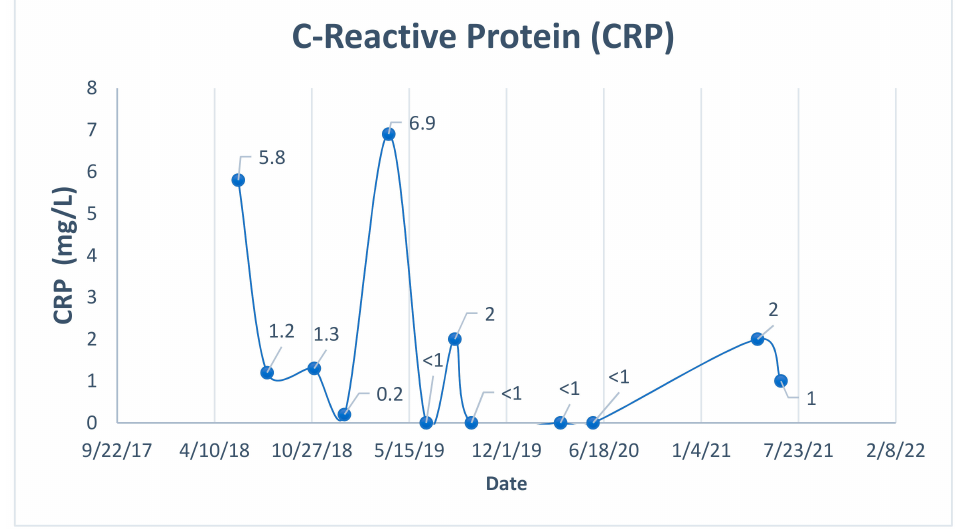
Figure 2. C-reactive protein results (10 April 2018–17 June